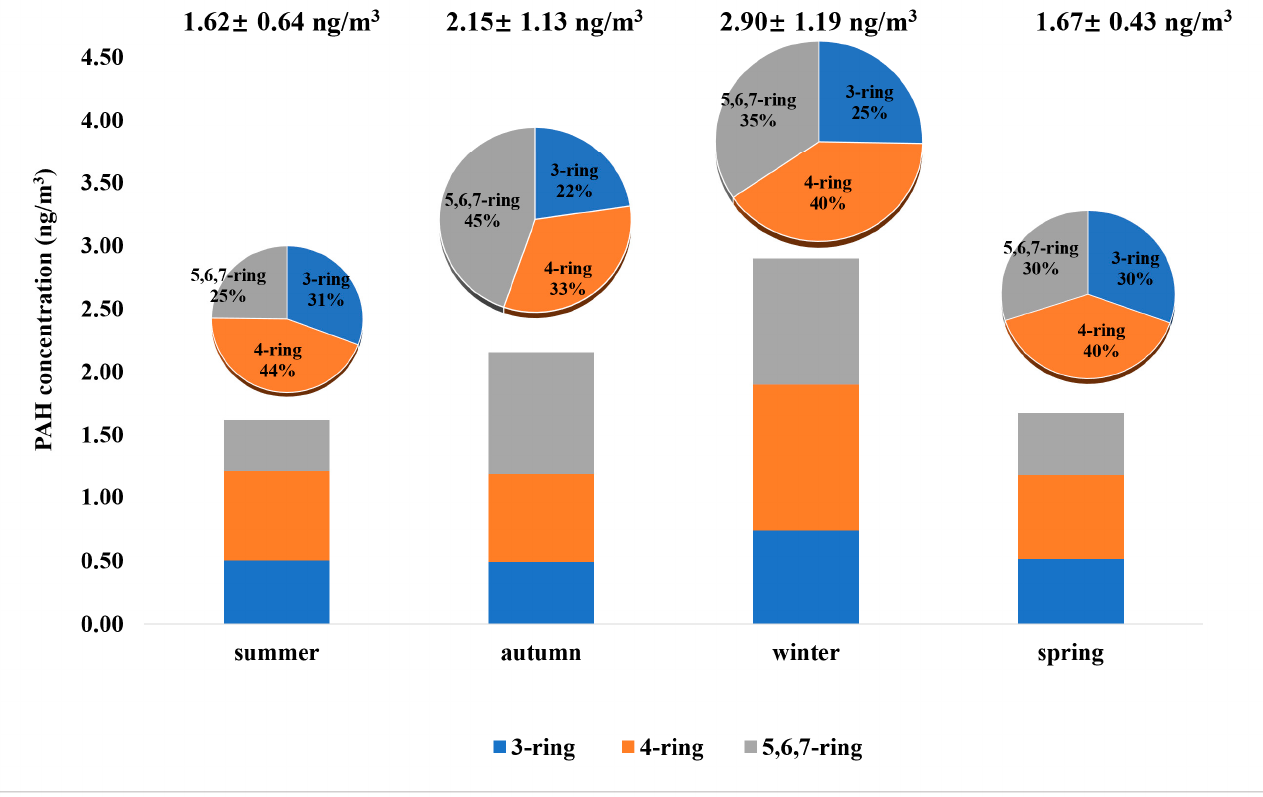
Figure 3. Relative concentrations of the 3-, 4-, and 5,6,7-ring groups in different seasons (unit: ng/m 3 ; blue: 3-ring PAH species, orange: 4-ring PAH species, grey: 5,6,7-ring PAH species).